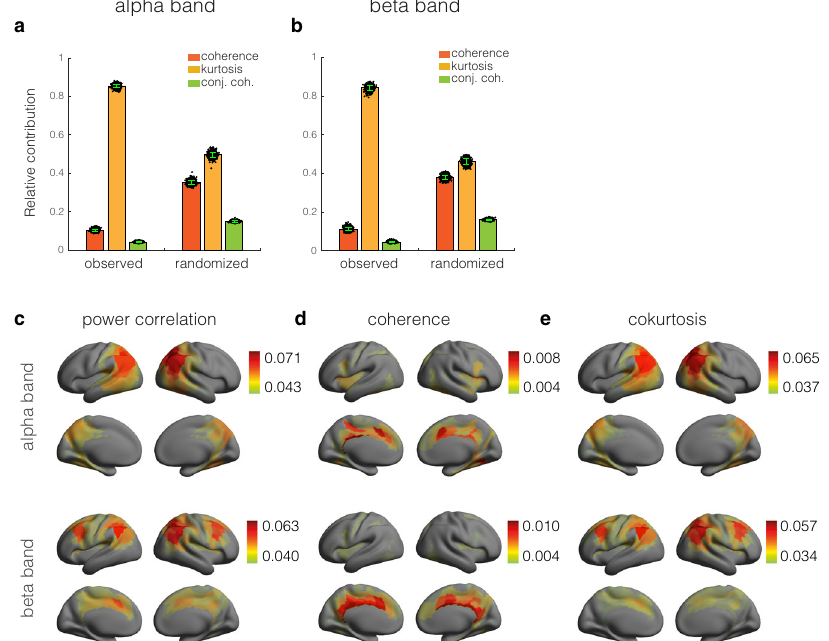
Fig. 5 Effect of signal orthogonalization. a Relative average contributions of coherence (dark orange bars), cokurtosis (light orange bars), and conjugate coherence (green bars) to cortical power correlations in the alpha frequency band. The contributions obtained from a randomized copy of the MEG sensor signals are also shown. b Same format as ( a ) but for the beta frequency band. The black dots in panels ( a ) and ( b ) quantify the statistical uncertainty of the relative contributions and were obtained by bootstrapping over subjects (1000 bootstrap realizations). The corresponding standard errors are also shown (green vertical bars). c Colour-coded cortical maps of the region-averaged power correlation network (i.e. the row-averaged power correlation matrix) in the alpha (top) and beta (bottom) frequency bands. d Colour-coded cortical maps of the region-averaged coherence network (i.e. the row-averaged power coherence matrix) in the alpha (top) and beta (bottom) frequency bands. e Colour-coded cortical maps of the region-averaged cokurtosis network (i.e. the row-averaged power cokurtosis matrix) in the alpha (top) and beta (bottom) frequency bands. For better visibility, the cortical maps were thresholded at their average